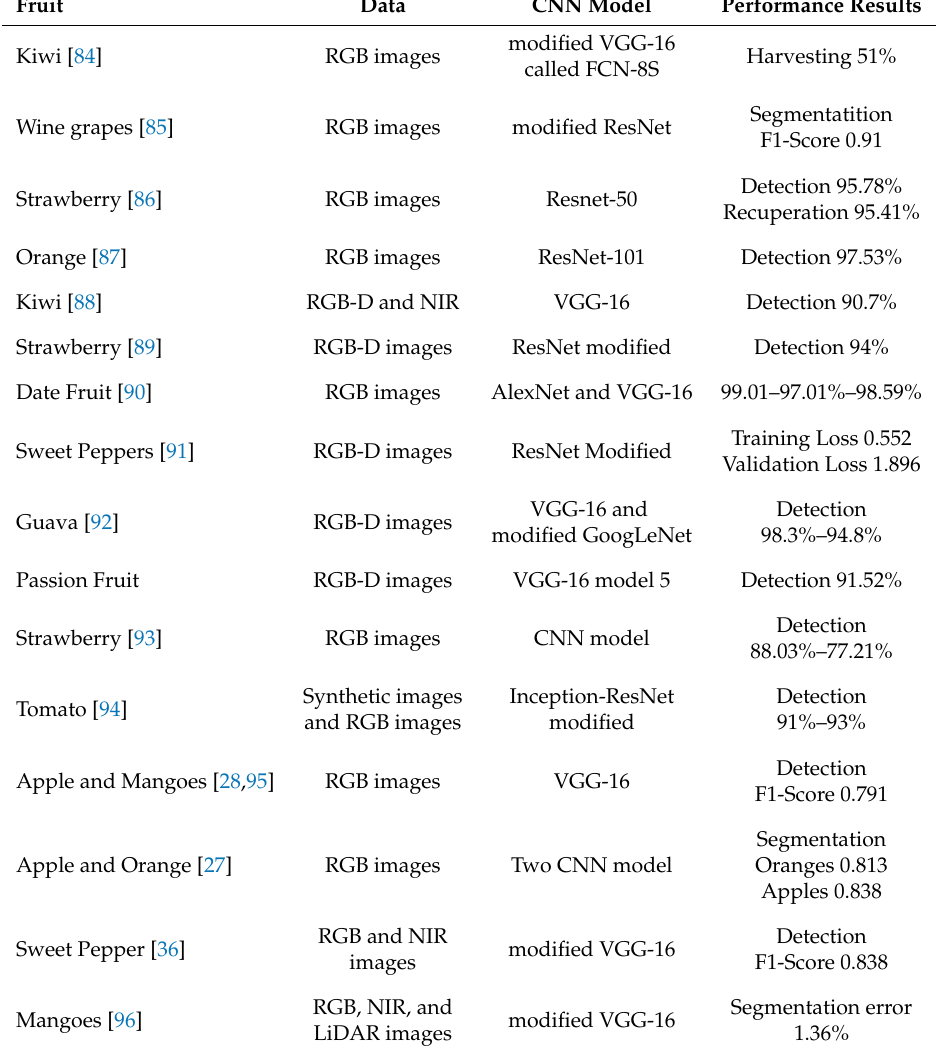
Table 3. Summary of state-of-the-art Convolutional Neural Network (CNN)-based approaches applied to the detection of fruits for automatic